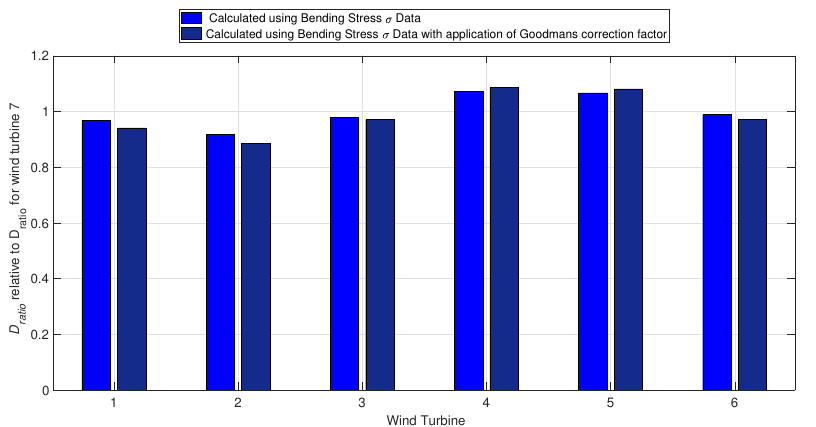
Figure 25. Normalised D ratio using bending stress σ with and without the application of the Good- man’s correction factor for a range of wind turbines.